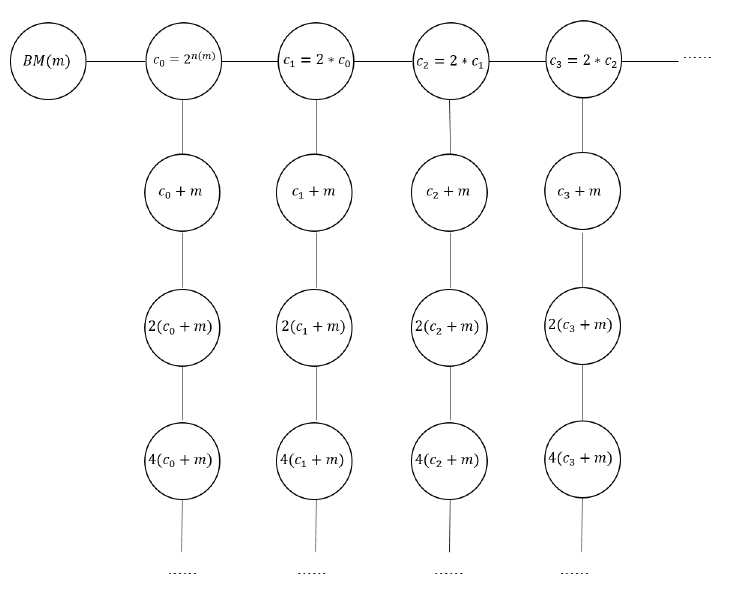
Figure 2: Simplified